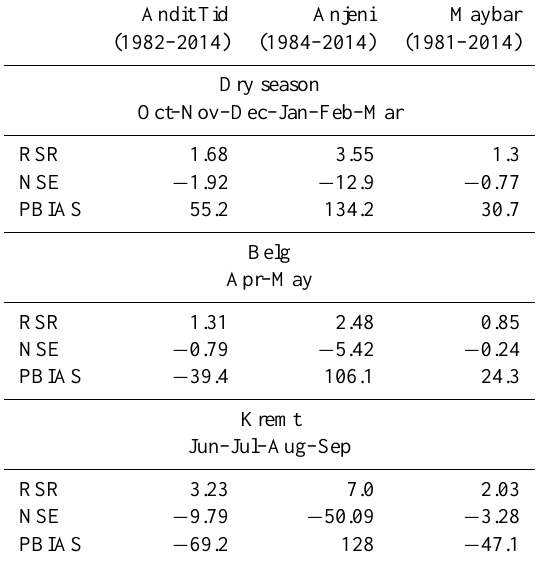
Table 4. Seasonal comparison of rainfall time series of daily rainfall amounts. Satisfactory performance ratings are highlighted in bold. Details for duration and gaps can be found in Table 1. Andit Tid Anjeni